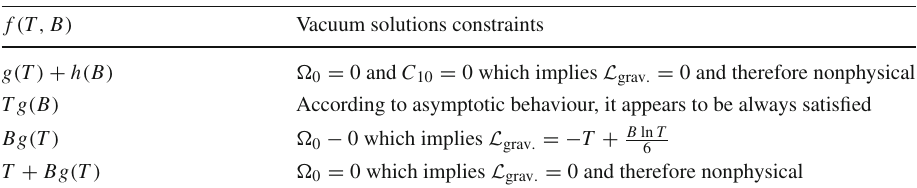
Table 9 A summary of the vacuum solution constraints for the case of matter bounce cosmology reconstruction. Overall, only the Tg ( B ) and Bg ( T ) model obey the